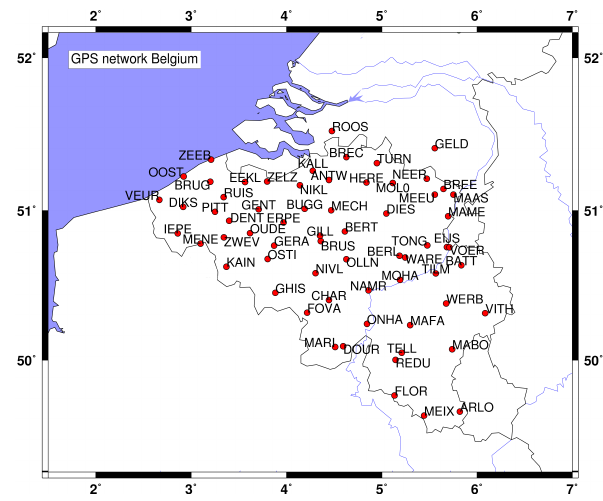
Figure8. BelgiandensenetworkofGPSstations. Figure 8. Belgian dense network of GPS 1140